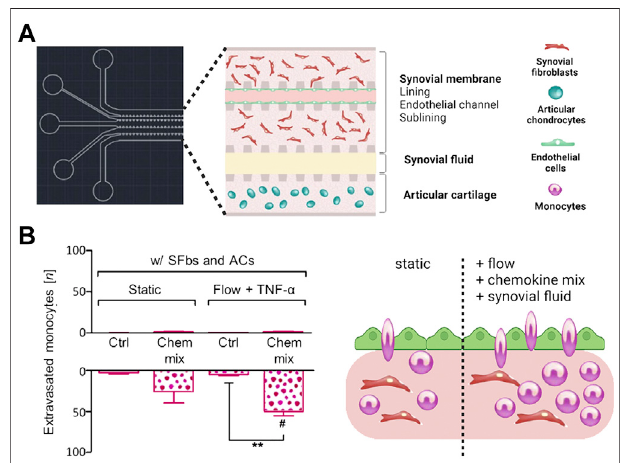
FIGURE 8 | Flow regimes alter immune cell migration in more holistic in vitro joint tissue studies. (A) A multicompartment biochip with heterotypic triple cultures comprising articular chondrocytes (blue cells) and an endothelialized synovial membrane model (turquoise endothelium with red FLS) for monitoring of monocyte extravasation and tissue in fi ltration processesinOAsynovialtissue. (B) Thecombinationof fl owwithsynovial fl uid and chemokines increases the number of extravasated monocytes within the synovial tissue compartment. Reproduced with permissions from (Mondadori et al., 2021).